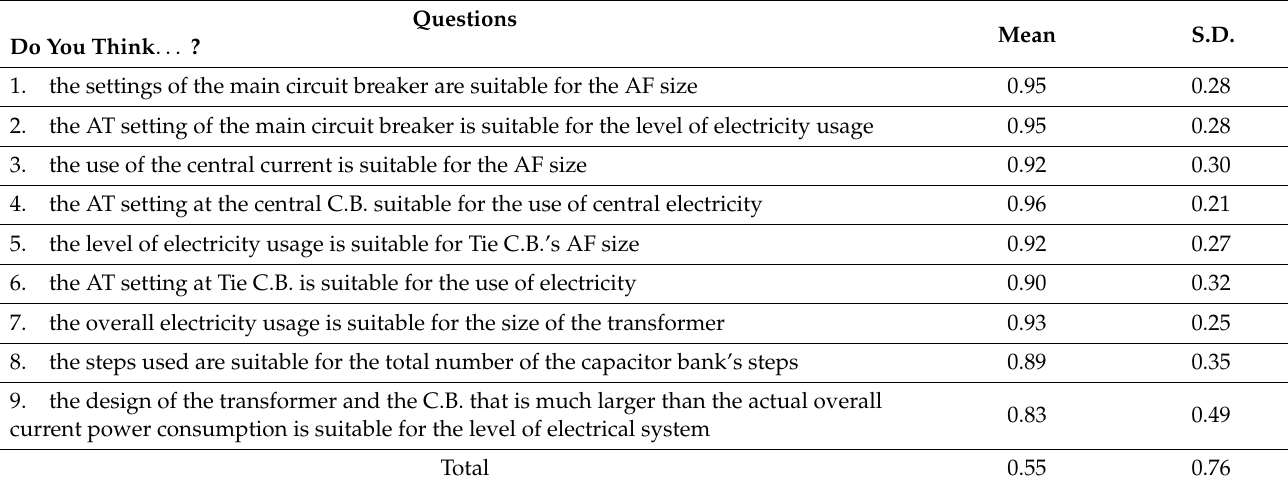
Table 1. Mean and standard deviation of caretakers’ assessments of the suitability of electrical